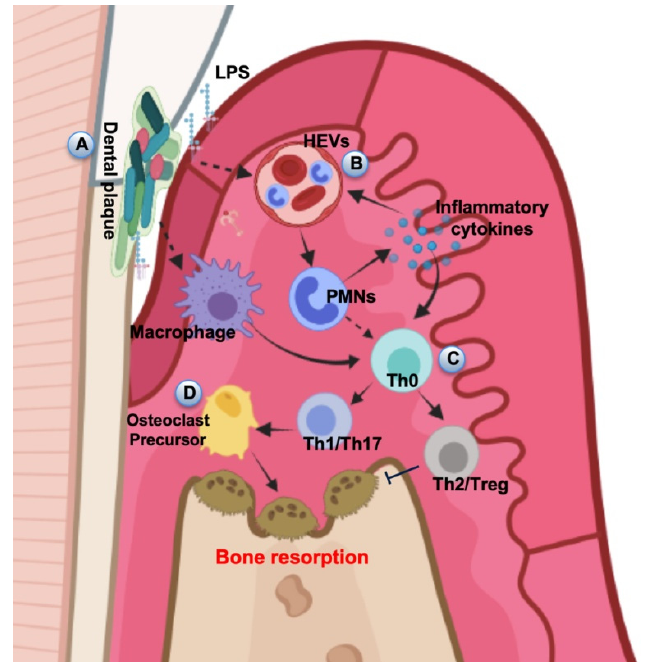
Figure 2. A diagram by Jiang et al. [49]. ( A ) In periodontal tissue, the dental plaque stimulates local inflammatory and immune responses. ( B ) LPS and other plaque PAMPs as well as DAMPs activate the HEVs leading to vascular hyperpermeability and leakage PMN transmigration. ( C ) APCs interact with naive T helper cells, driving their differentiation into several subsets. ( D ) The amplification of local immune response leads to the development of inflammation and results in the progression of periodontal destruction and bone resorption. Under the terms of the Creative Commons Attribution License (CC BY).